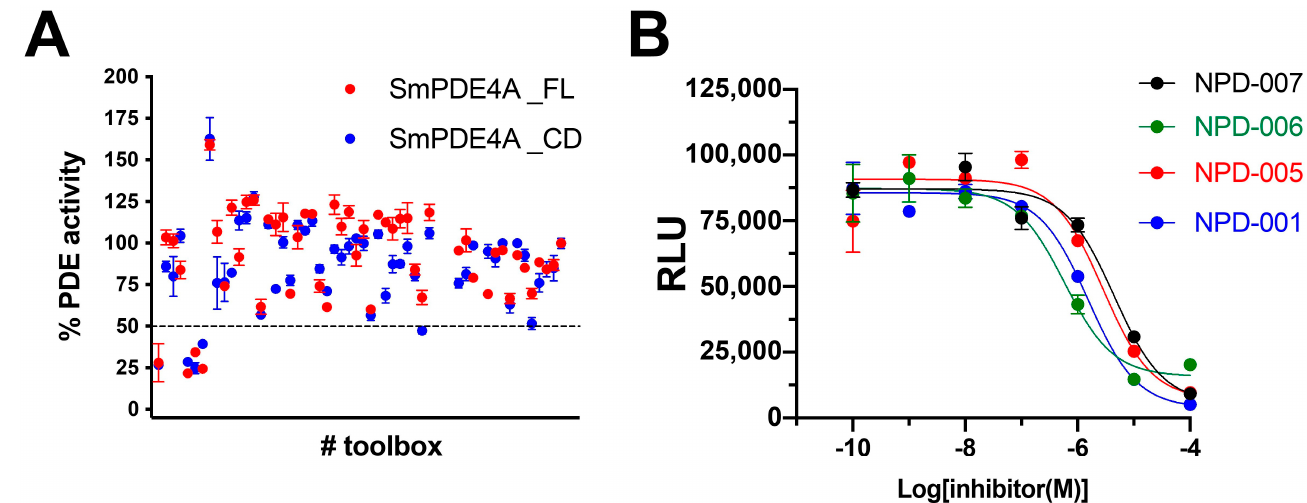
Figure 4. PDE4NPD Toolbox screen to identify inhibitors of SmPDE4A. ( A ) Inhibition of SmPDE4A_FL (red circles) and SmPDE4A_CD activity (blue circles) after incubation with PDE inhibitors at 10 µM. ( B ) Representative dose-response curves for inhibition of the enzymatic activity of SmPDE4A_CD with the toolbox hits NPD-0001 (blue; pIC 50 = 5.8 ± 0.06), NPD-0005 (red; pIC 50 = 5.5 ± 0.14), NPD-0006 (green; pIC 50 = 6.2 ± 0.10) and NPD-0007 (black; pIC 50 = 5.4 ± 0.11). Table 1. p K i values of the PDE4NPD Toolbox hits for the inhibition of SmPDE4A_CD. Comp No.